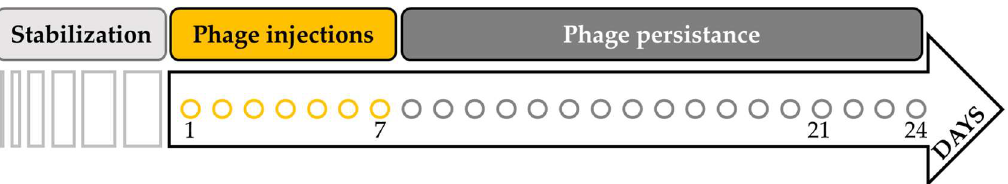
Figure 2. Timeline of the SHIME experiment. After the inoculation of human feces in the ascending, transverse, and descending colons, the microbiota needed 23 days for stabilization. Then, 10 mL at 10 9 (PFU/mL) of the phage ULIP33 was injected in the ascending colon for 7 days (from day 1 to day 7). The experiment was maintained until the disappearance of the phage from the system (corresponding to day 24 for repetition 1 and day 21 for repetition 2 and 3).